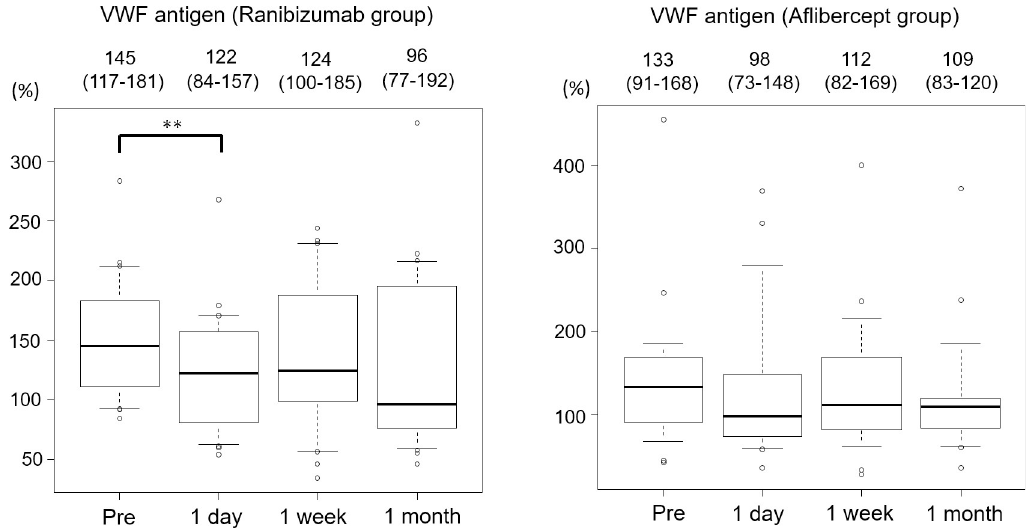
Fig 6. Alterations of VWF antigen in patients with branch RVO according to the administered drug. Each of the values above the graph presents the median with the interquartile range. � < 0.05, �� < 0.01. RVO, retinal vein